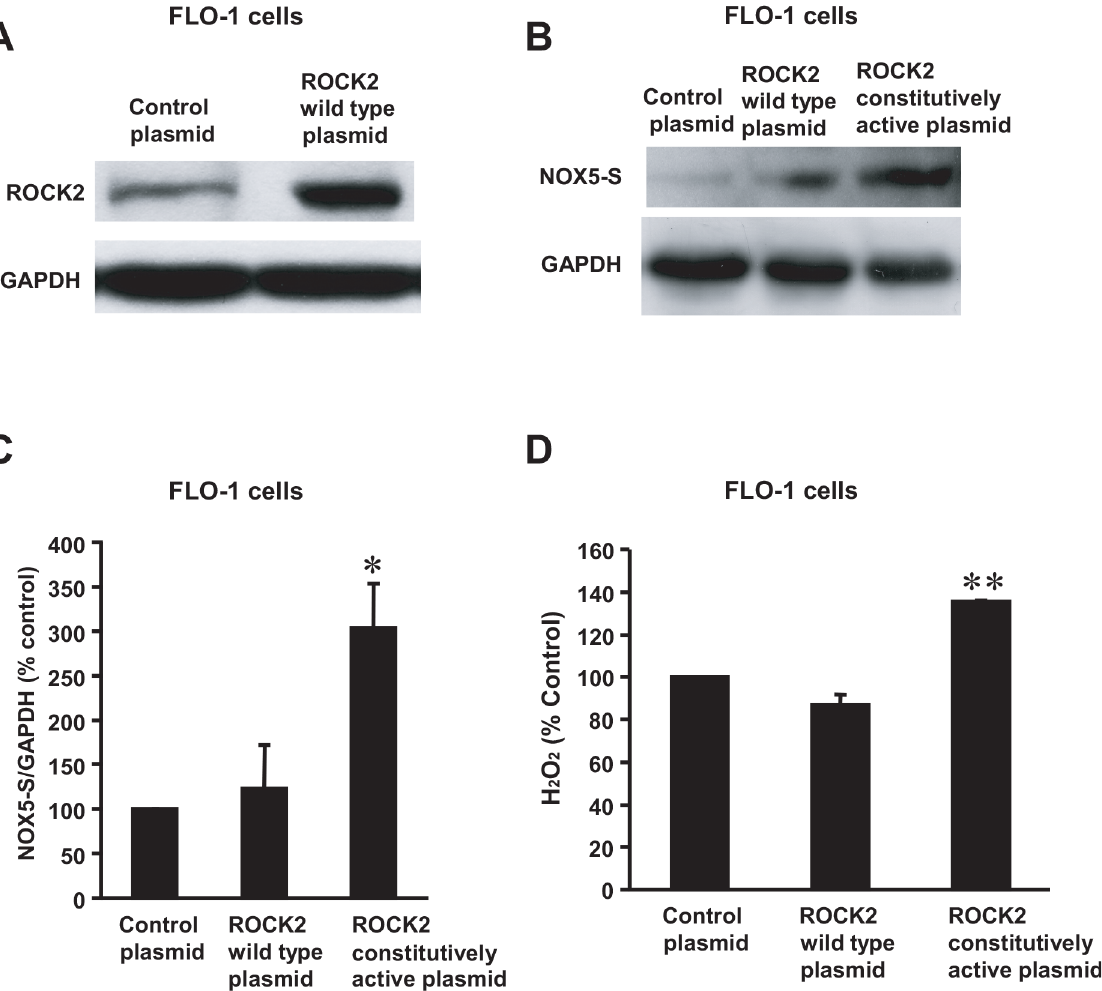
Fig 4. NOX5-S expression and H 2 O 2 production in FLO-1 EA cells after ROCK2 overexpression. (A) A typical example of three Western blot analysis showed that ROCK2 protein was successfully overexpressed in FLO-1 cells after transfection with ROCK2 expression plasmid. (B) A typical example of three Western blot analysis and (C) summarized data showed that overexpression of constitutively active ROCK2 significantly increased NOX5-S protein expression. (D) Overexpression of constitutively active ROCK2 significantly increased H 2 O 2 production in FLO-1 EA cells. The data suggest that ROCK2 may contribute to acid-induced increase in NOX5-S expression and H 2 O 2 production. N = 3, ANOVA, * P < 0.03, ** P < 0.001, compared with control plasmid